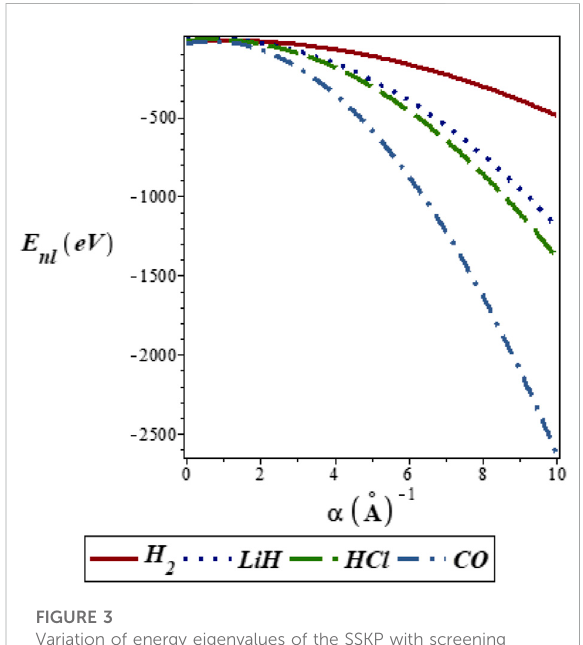
FIGURE 5 Variation of energy eigenvalues of the SSKP with vibrational quantum number for different diatomic molecule systems with l = 1.